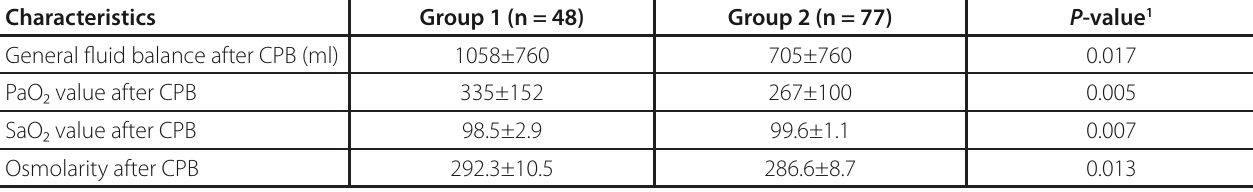
Table 3. Comparison of perioperative fluid treatment and ventilator values according to groups.